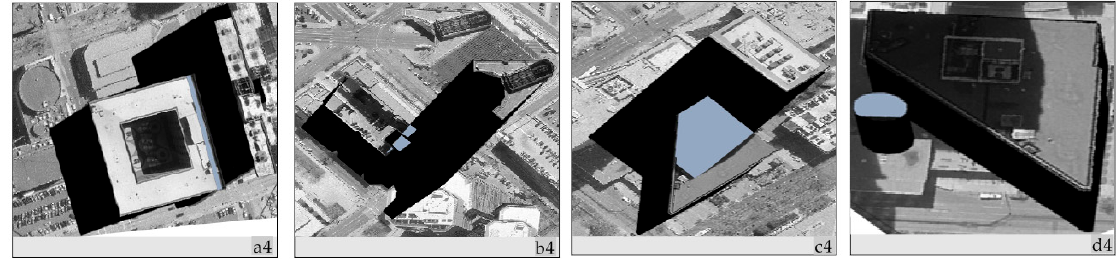
Figure 12. The results of detection from the buildings.